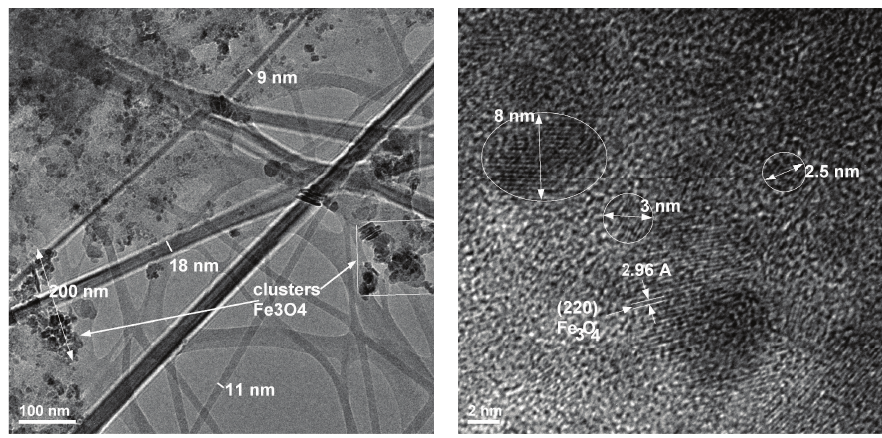
Figure 6: TEM and HR-TEM images of BC/magnetite membranes with 5% MNP